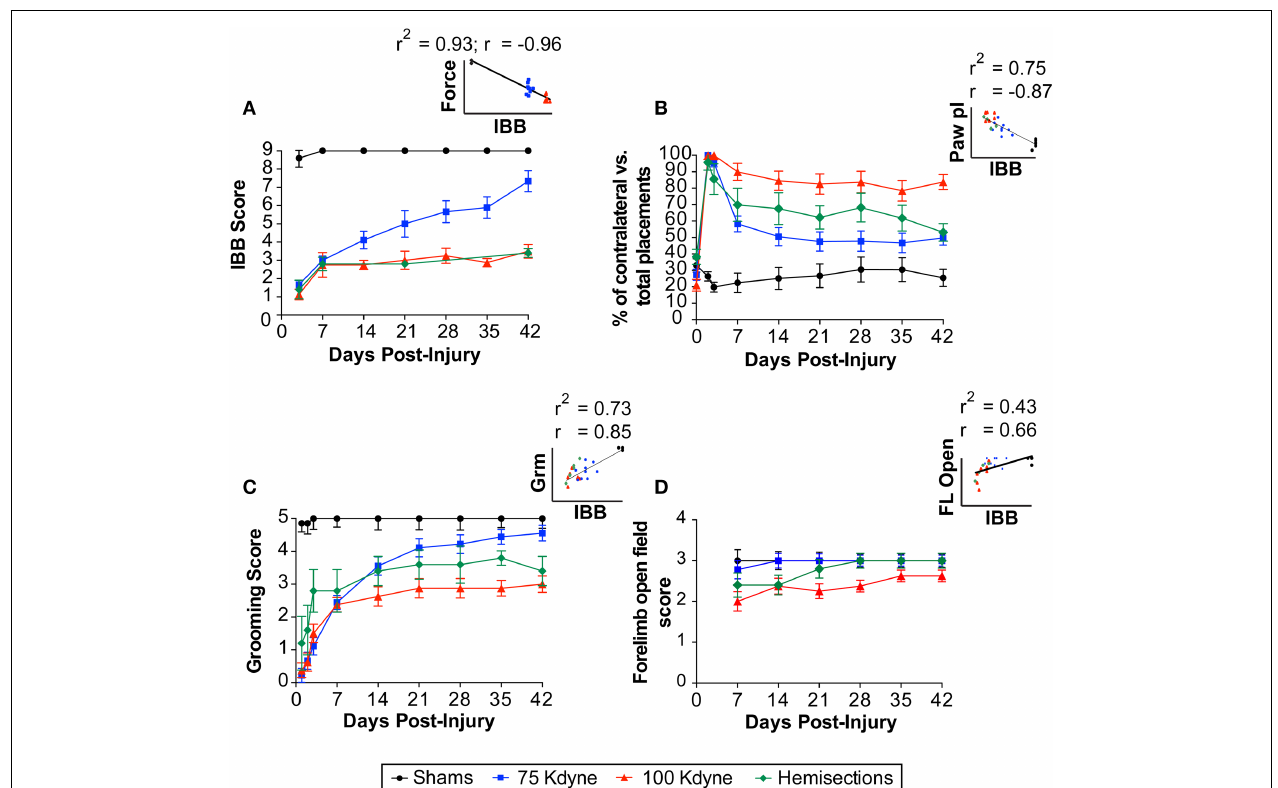
established outcomes including (B) paw placement, (C) grooming score, and (D) forelimb open field. Insets reflect the scatterplot and regression line between the IBB and each of the established tests.The Pearson correlation ( r ) and the shared variance ( r 2 ) for each appear above the scatterplot; group identity for each point is color